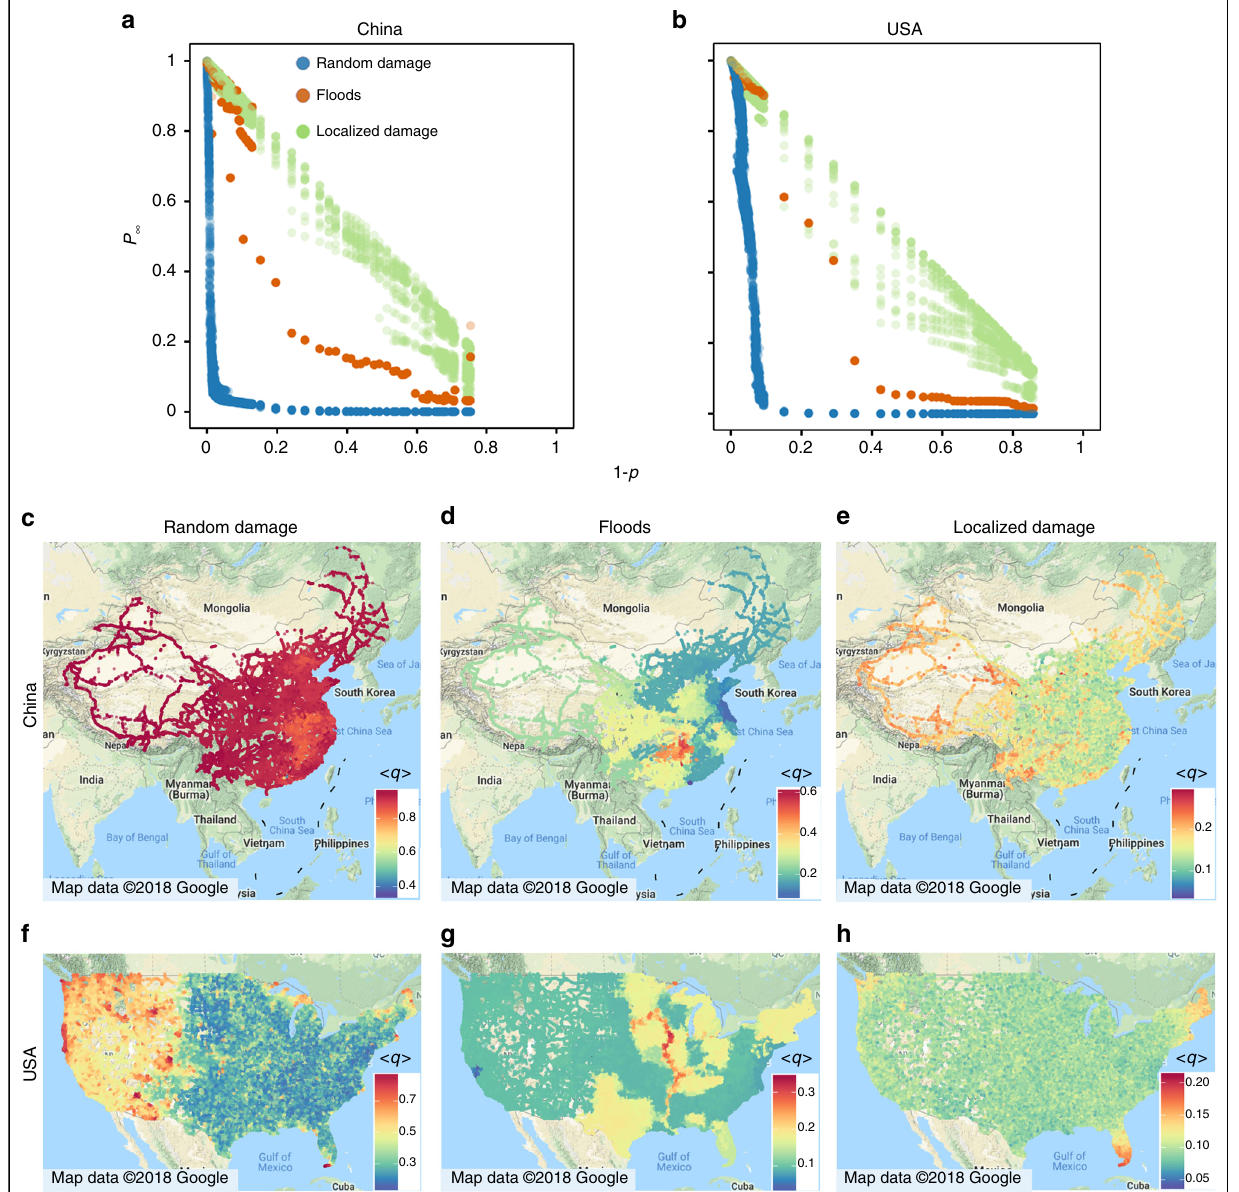
Fig. 3 Features of fl ood-induced failures. Fraction of nodes in giant connected component ( P ∞ ) in China a and the US b as a function of the fraction of nodes that are direct failures (1 − p ). Each road intersection is coded by color according to the vulnerability to total failure due to random damage ( c Supplementary Table 2. We only consider road intersections in the giant connected component of the original road network. Simulation results are the outcome of 20 independent global simulation runs and 20 regional simulation